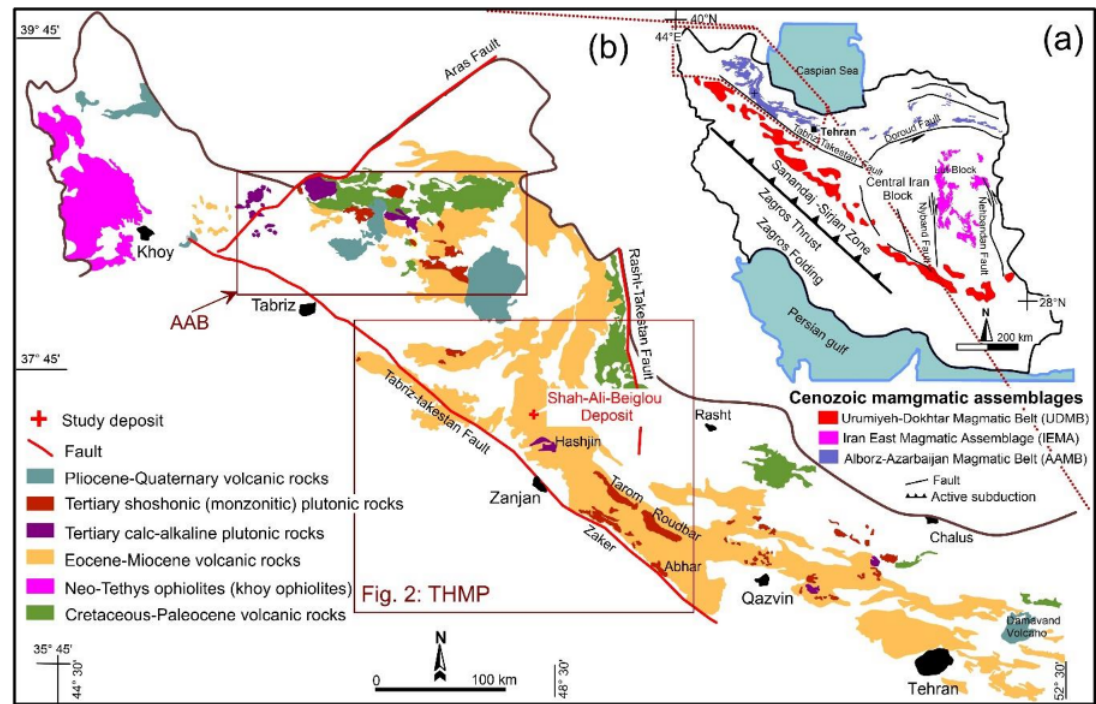
Figure 1. ( a ) Distribution of the Cenozoic magmatic assemblages in Iran [6]; ( b ) Geological schematic map showing the main rock units and structures of the Alborz-Azarbaijan magmatic belt, the location of the Ahar-Arasbaran belt (AAB) and Tarom-Hashjin magmatic province (THMP), and the location of the study area in NW Iran; reproduced with permission from [21], published by Elsevier B.V.,